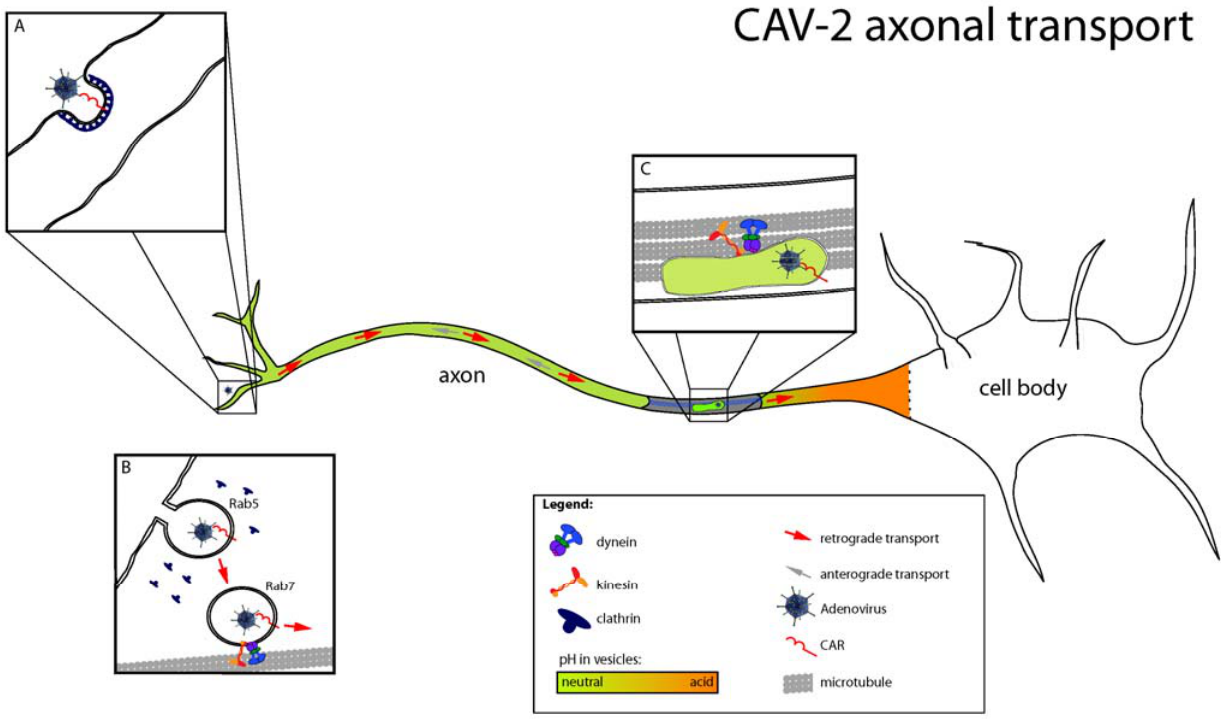
Figure 2. Different steps of CAV-2 axonal transport. (A) After binding to CAR at the cell surface, CAV-2 is internalized in clathrin-coated pits. (B) During entry, maturation of CAV-2 containing vesicles occurs, with a shift from Rab5 to Rab7 endosomes that will eventually lead to CAV-2 axonal transport. Despite Rab7 maturation, the pH of axonal endosomes stays neutral, and CAV-2 remains inside vesicles during transport. (C) CAV-2 traffic involves dynein and kinesin, with a bias for the retrograde direction. CAR is still found in CAV-2 positive vesicles. (Image modified from Henaff and Salinas, Virulence